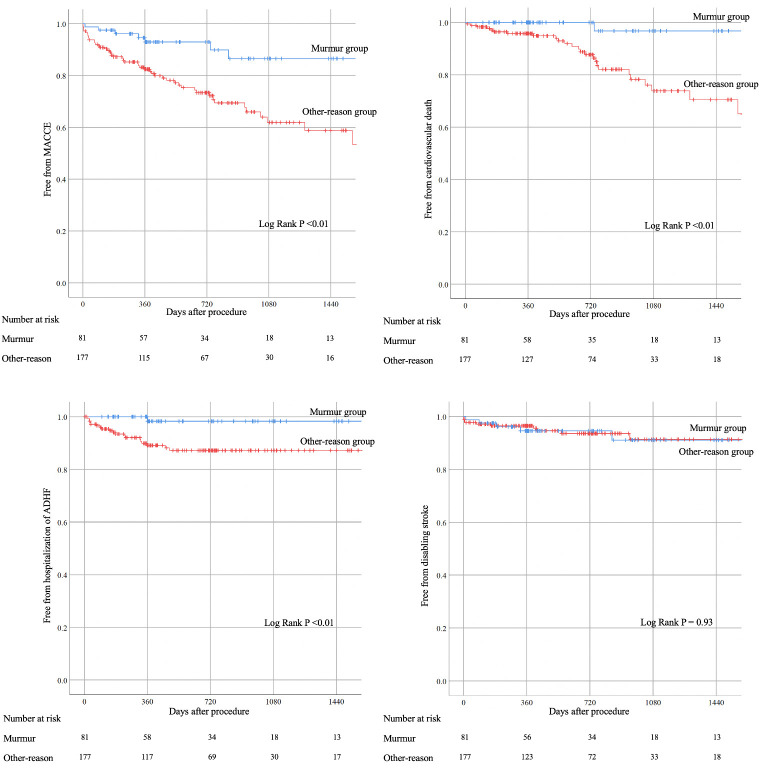
Kaplan-Meyer survival curve analyses.MACCE, major adverse cardiovascular or cerebrovascular events: Composite of cardiovascular death, history of hospitalization of acute de-compensated heart failure (ADHF), and disabling stroke.